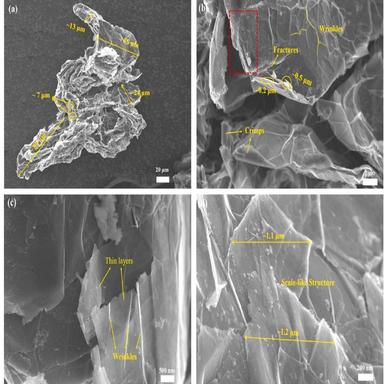
SEM images of exploding a graphite plate underwater at a stored energy of 250 J.